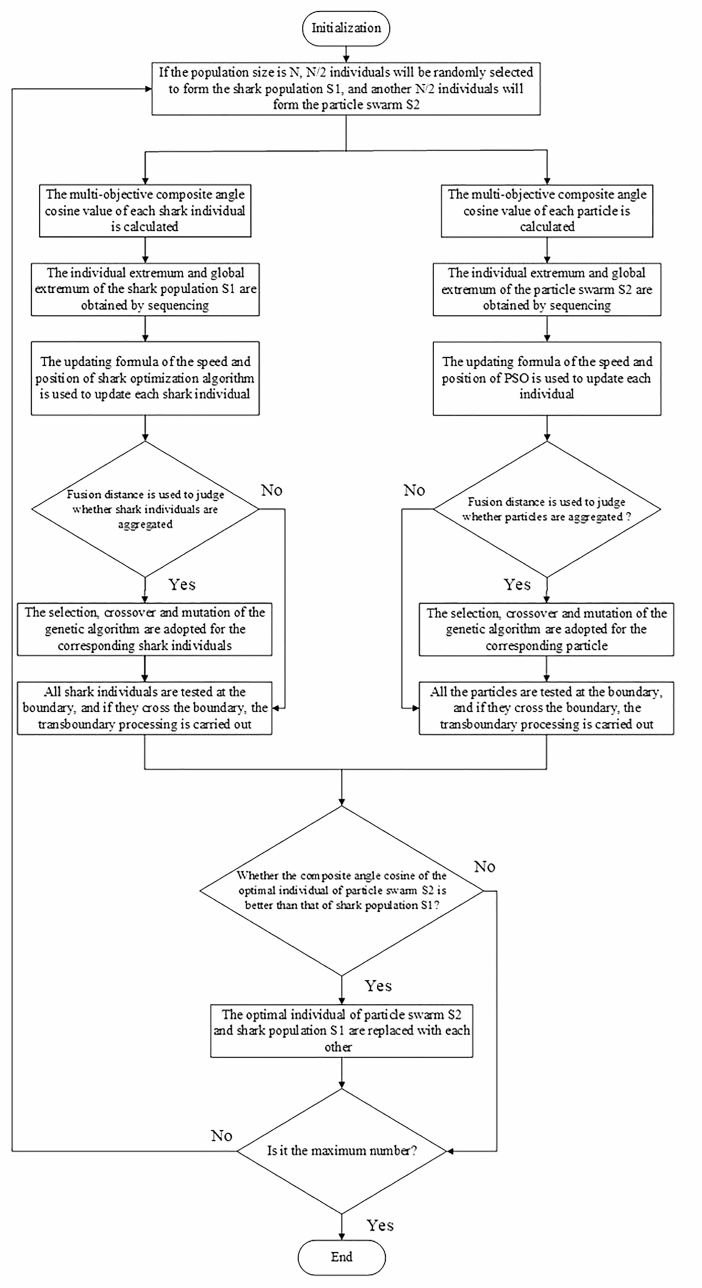
Figure 4. The flowchart of improved shark smell optimization algorithm proposed in this